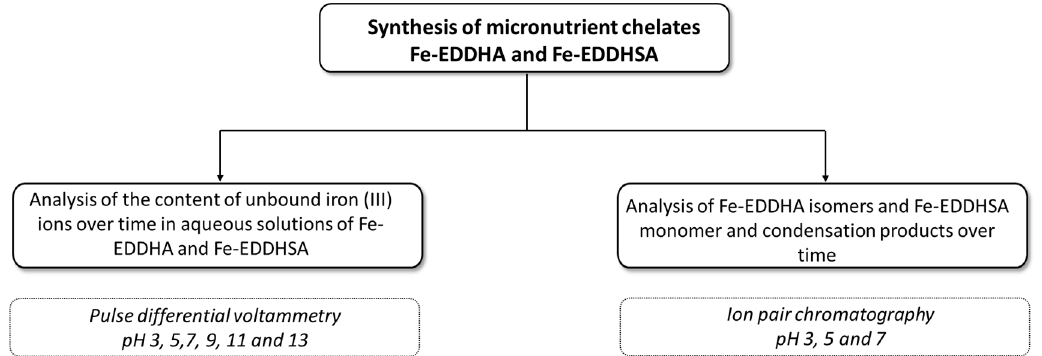
Figure 14. Scheme of analyses performed to determine the chemical stability of Fe-EDDHA and Fe-EDDHSA microelement chelates.